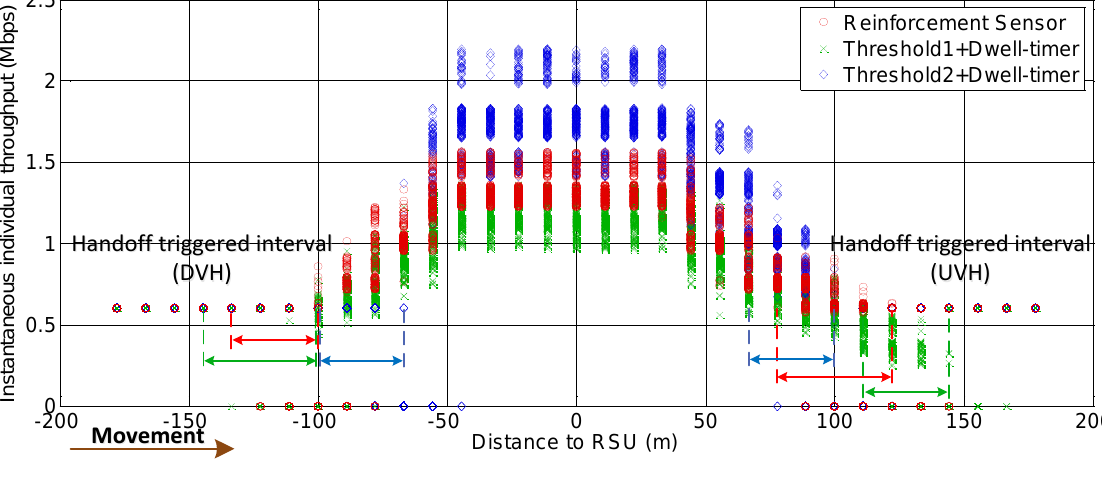
Figure 10. Instantaneous individual throughput vs. distance to RSU (arrival rate = 0.3